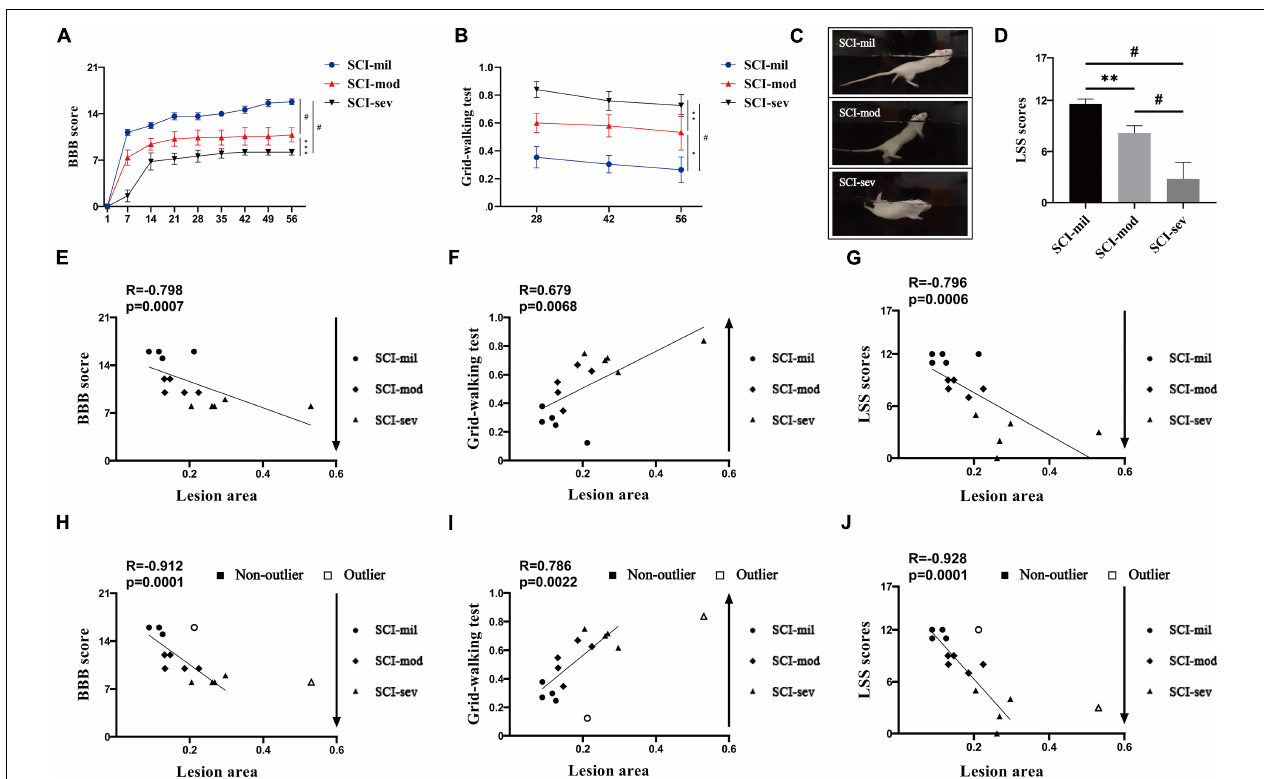
FIGURE 3 | Experience-dependent methods of behavioral testing and Spearman’s rank correlation coefficient test. Various levels of spontaneous recovery, comparison among three groups on (A) BBB score and (B) grid-walking test, were evaluated by experience-dependent methods in rats that underwent contusion of three different severities. (C,D) Photographs of swimming test and comparison among three groups on LSS scores. n = 5 per group ( ∗ p < 0.05; ∗∗ p < 0.01; ∗∗∗ p < 0.001; # p < 0.0001; ns represents no statistical significance). Spearman’s rank correlation coefficient test. (E–G) Correlation analysis between lesion area and experience-dependent methods of behavioral testing including outliers. (H–J) Correlation analysis between lesion area and experience-dependent methods of behavioral testing after removing outliers.